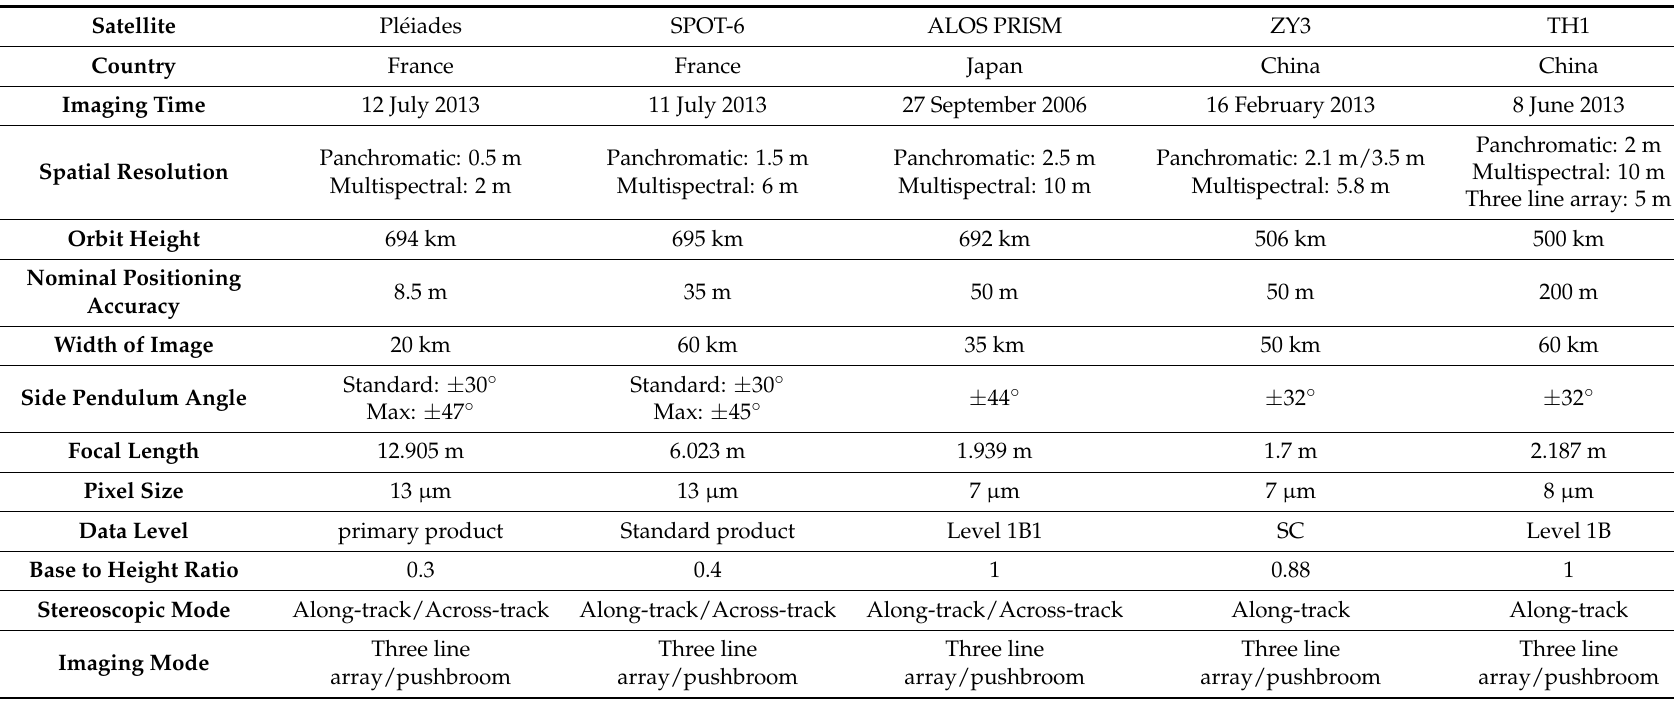
Table 2. Characteristics of satellite imagery in the Xianning test field. PAN: panchromatic, GSD: Ground Sample Distance. Satellite Pl é iades